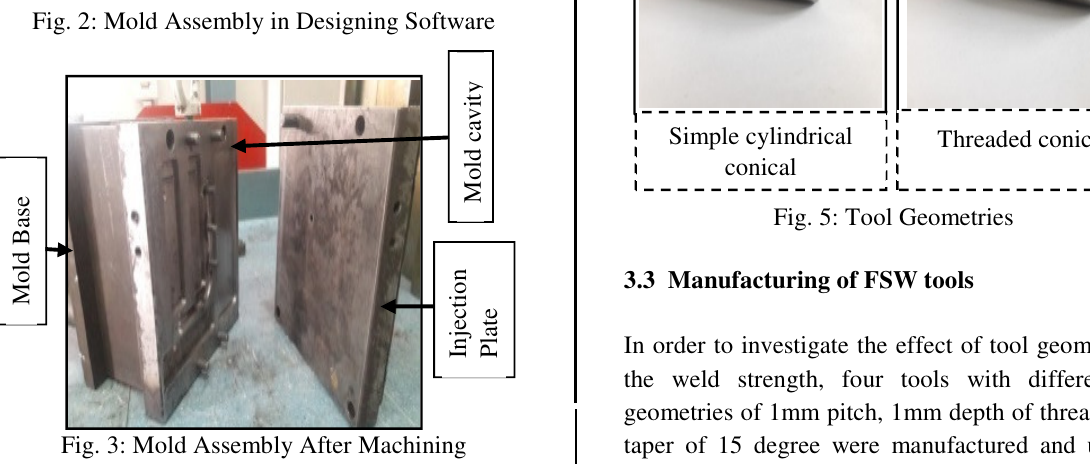
Fig. 2: Mold Assembly in Designing Software